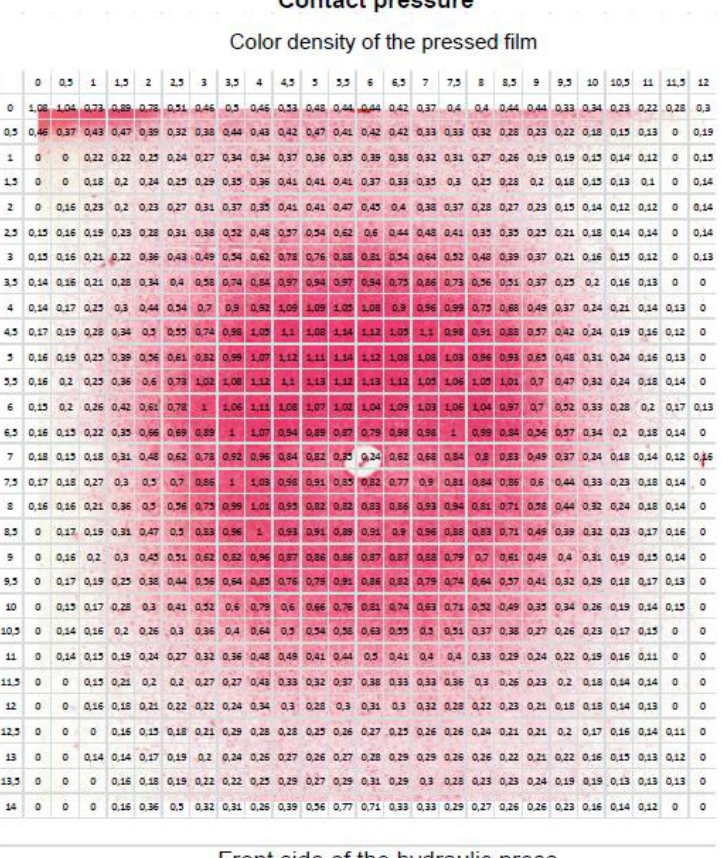
Figure 5. The force press track over the 120 × 140 mm film.